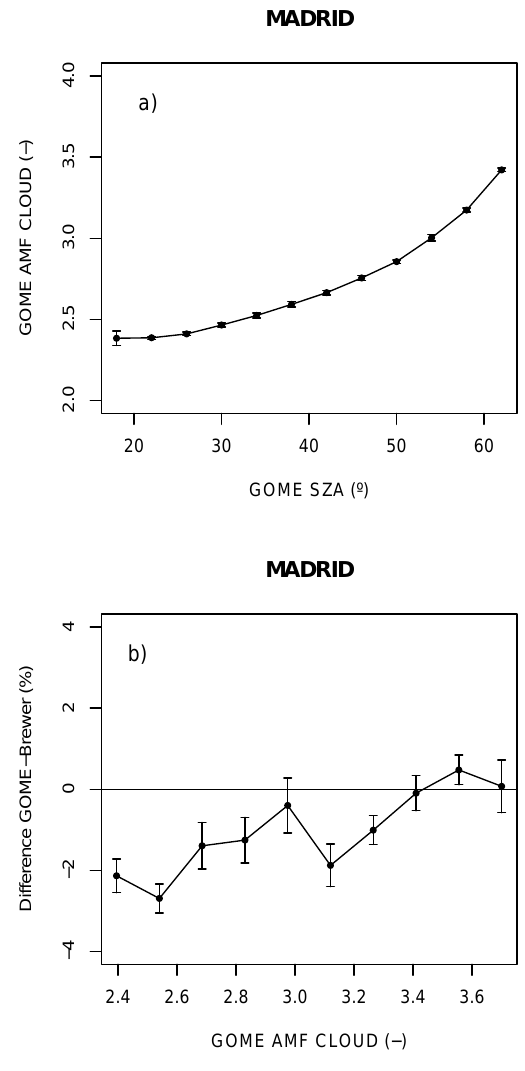
Fig. 9. (a) Dependence of AMF parameter with solar zenith an- gle for the Madrid station. (b) Variation of GOME-Brewer relative differences with the AMF parameter at the Madrid